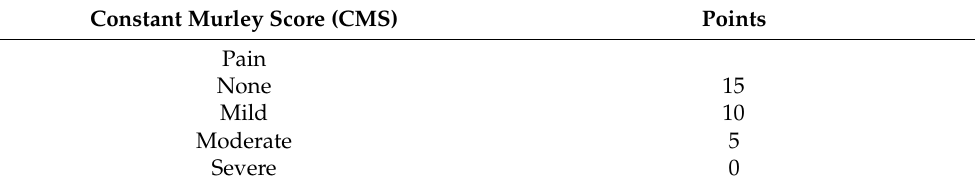
Table 1. Constant Murley Score (CMS)